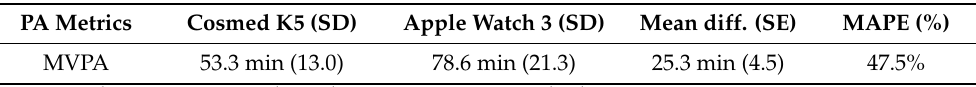
Figure 2. Equivalence Testing for MVPA and AEE estimates between the K5 and Apple Watch 3. CI: Confidence interval; EZ: Equivalence zone; MVPA: Moderate-to-vigorous physical activity; EE: Energy Expenditure; vertical dashed lines show the actual bounds within which the Apple Watch 3 is statistically equivalent to the K5 for MVPA and Active EE estimates. bias (Mean difference: − 25.3 ± 4.5) and high MAPE (47.5%) in estimating time spent in MVPA compared to the estimates from the GT3X+ in the free-living condition (Table 3). Table 3. Estimated mean (SD), mean difference (SE), mean absolute percent error between the GT3X+ and Apple Watch 3 under the free-living condition.